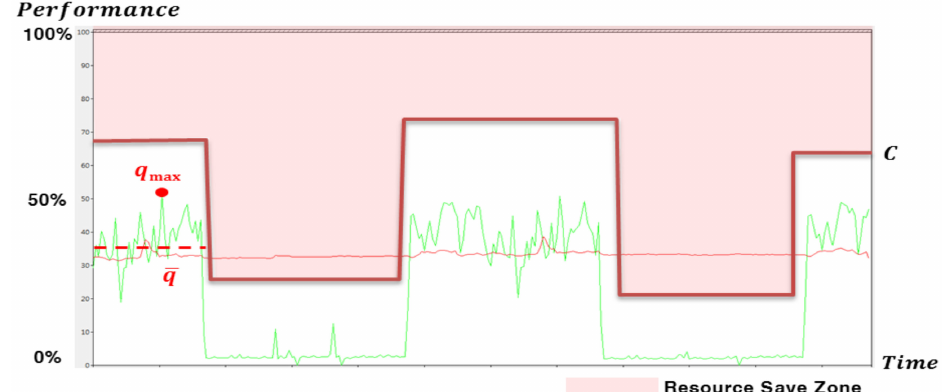
Figure 7. VDI resource